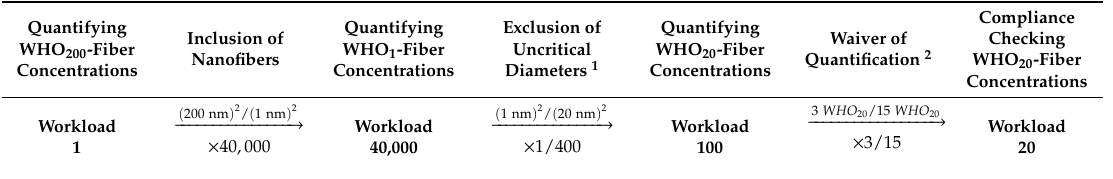
Table 1. Workload reduction approach of the proposed compliance check strategy in estimated in workload units relative to the workload for WHO-fiber